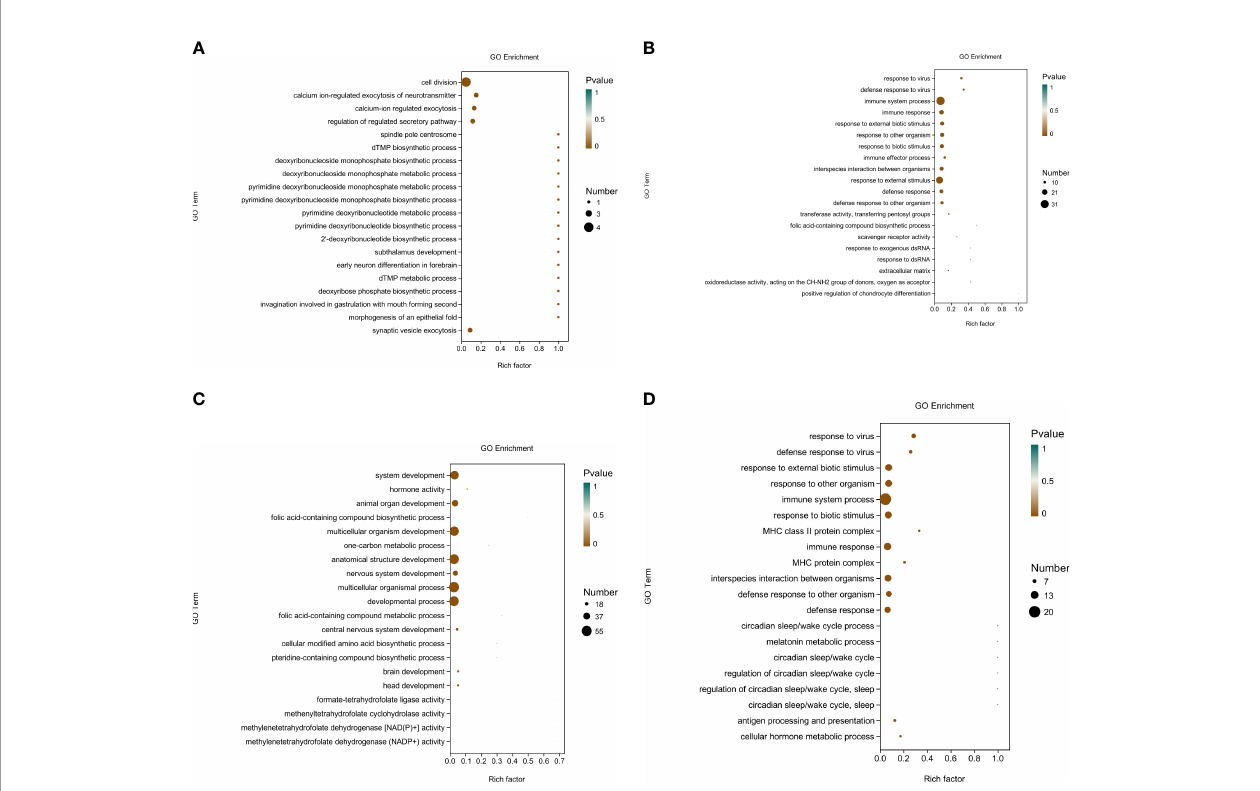
FIGURE 2 | The top 20 GO terms in each group. (A) Gene ontology (GO) annotation of the top 20 differentially expressed genes in the brain of Ctenopharyngodon idella following treatment with MS-222 at a low concentration. (B) Gene ontology (GO) annotation of the top 20 differentially expressed genes in the brain of Ctenopharyngodon idella following treatment with MS-222 at a high concentration. (C) Gene ontology (GO) annotation of the top 20 differentially expressed genes in the brain of Ctenopharyngodon idella following treatment with 2-phenoxyethanol (2-PE) at a low concentration. (D) Gene ontology (GO) annotation of the top 20 differentially expressed genes in the brain of Ctenopharyngodon idella following treatment with 2-phenoxyethanol (2-PE) at a high concentration.The abscissa indicates the richness factor (the number of DEGs annotated to a GO term/the total number of genes annotated to a GO term), and the ordinate indicates the GO terms. The size of the circles in the fi gure represents the number of genes annotated to the corresponding GO term (upregulated or downregulated in relation to the gene set selected in the analysis). The depth of color represents the level of